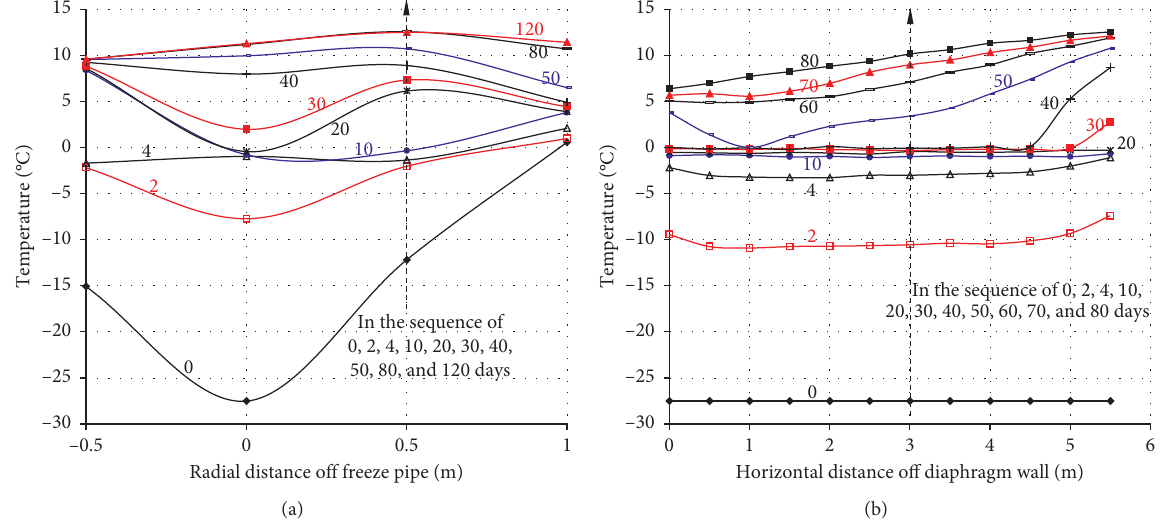
Figure 8: Variation of temperature with natural thawing time along the radial and longitudinal directions: (a) radial direction (Path 1); (b) longitudinal direction (Path